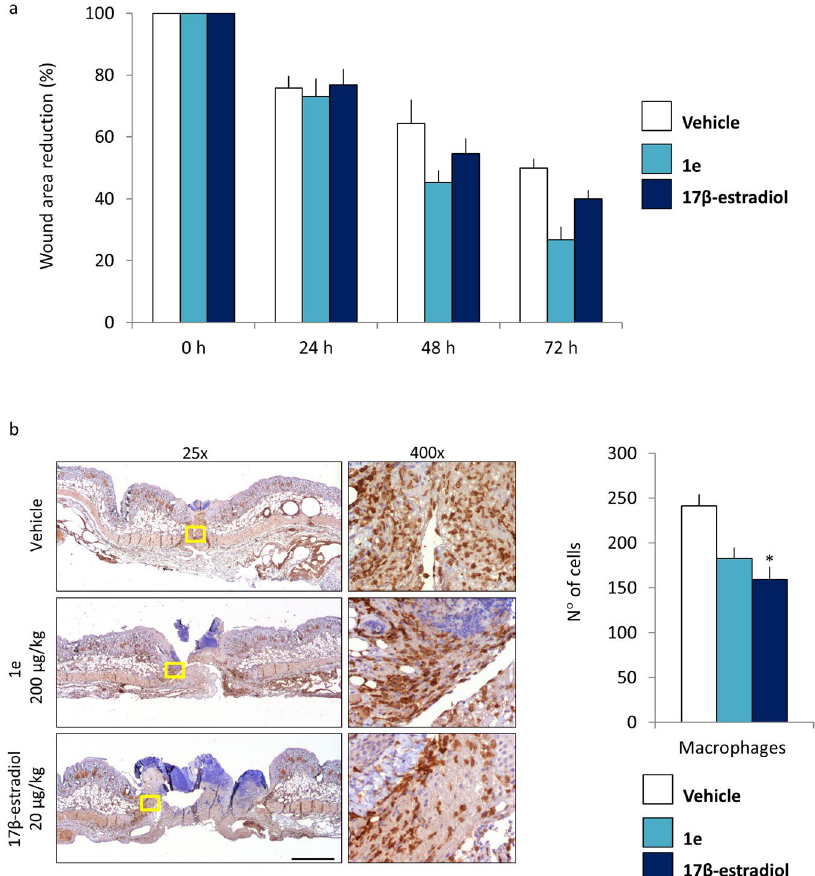
Figure 9. Reduction of the wound areas after treatment with 1e and 17 β -estradiol. ( a ) Wound area measurement: each bar represents the mean ratio versus time = 0 h + / − SEM expressed as percentage of wound area measured in 4 animals/group. ( b ) Representative staining of wound explants at 72 hours after treatments. Staining was done with Iba1 antibody. Pictures were taken at 25x and 400x. Bar = 2 mm. The number of macrophages cells around wound site: each bar represents the mean + / − SEM, macrophages (Iba1 positive cells) were counted by analyzing n = 6 fields (vehicle), n = 11 fields ( 1e ) and n = 10 fields (17 β -estradiol) at 400x enlargement. ( * p < 0.1 vs vehicle, ANOVA followed by Bonferroni’s test for multiple